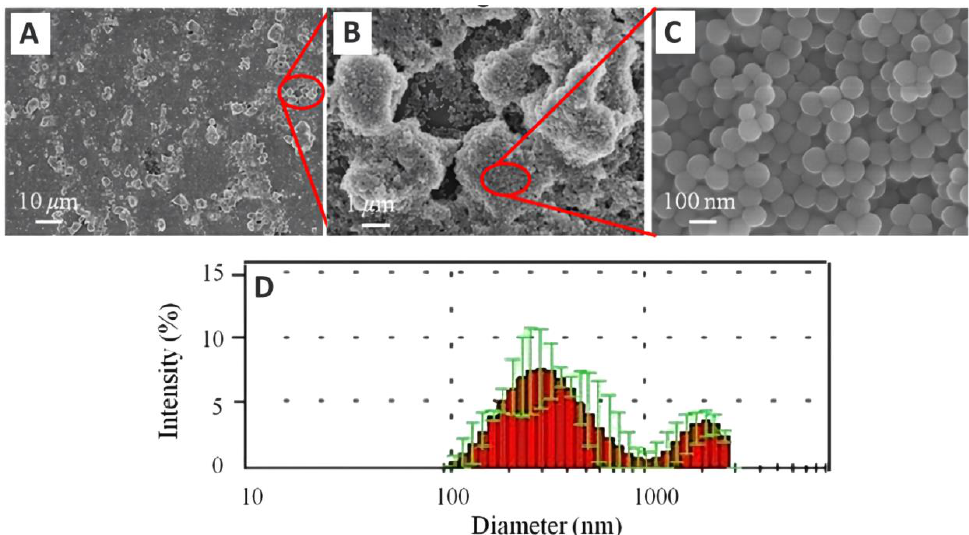
Figure 9. FE-SEM micrographs and particle size distributions of silica bimodal nanoclusters and magnified to varying degrees ,indicated with scale bars of 10 μm ( A ), 1 μm ( B ) and 100 nm ( C ) at selected regions, and their size distribution ( D ), respectively.Images from [96].